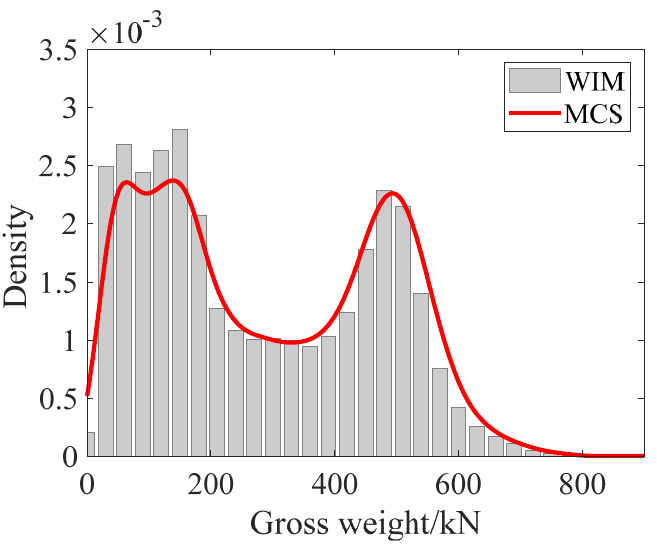
Figure 6. Comparison of monitoring and simulated probability distribution of gross vehicle weight.